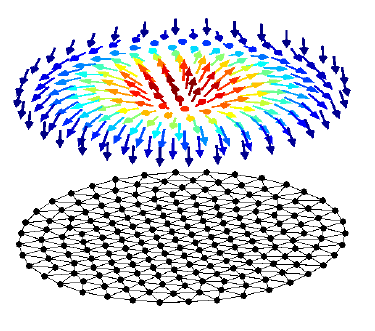
FIG. 7. Demonstration of Delaunay triangulation for a crystal with 200 ions. The triangulation is used to identify triplets of neighbors on the discrete lattice for computing the winding num- ber of the spin texture ( Q ) or that of the effective magnetic field texture ( W